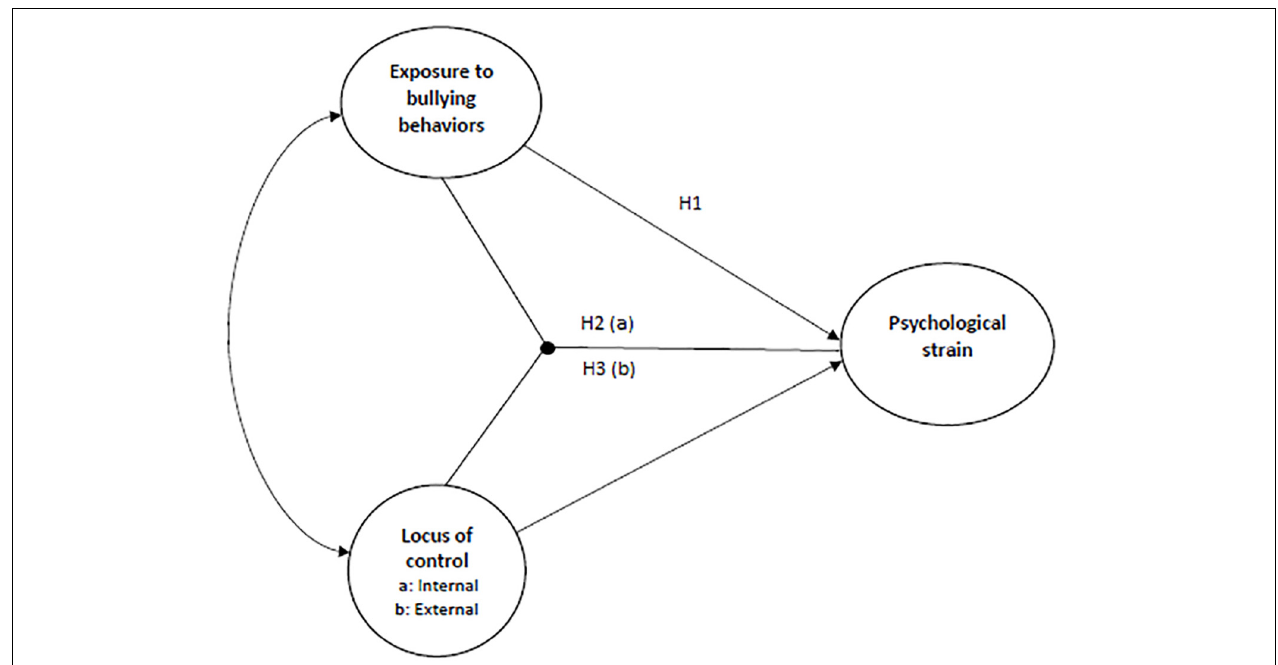
FIGURE 1 | Theoretical model of internal and external locus of control, respectively, as moderators in the bullying-psychological strain